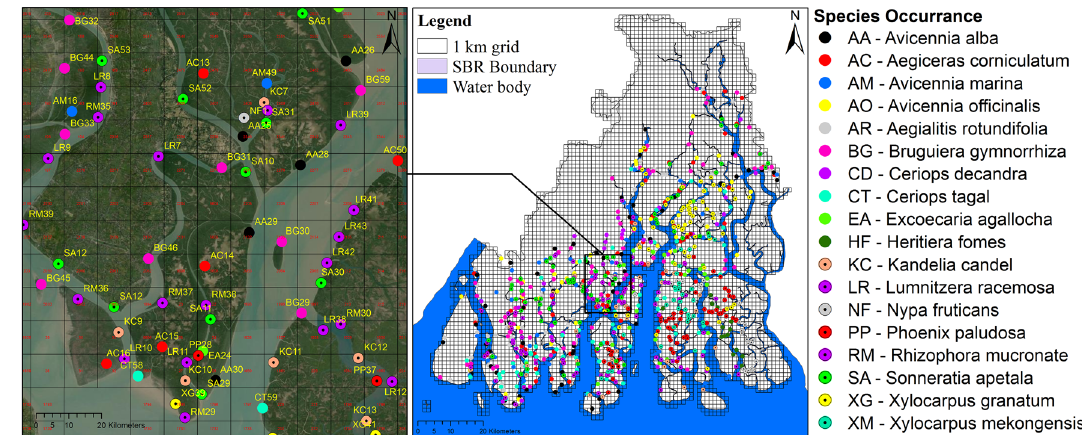
Figure 3. A grid-based field survey (2018–2019) has been conducted to collect the species occurrence data of 18 mangrove species. (The satellite images are obtained from the ArcGIS google earth base map. The species occurrence locations were collected through Garmin eTrex 32 × Outdoor Handheld GPS and the maps were prepared using ArcGIS 10.8.2 software [https:// deskt op. arcgis.